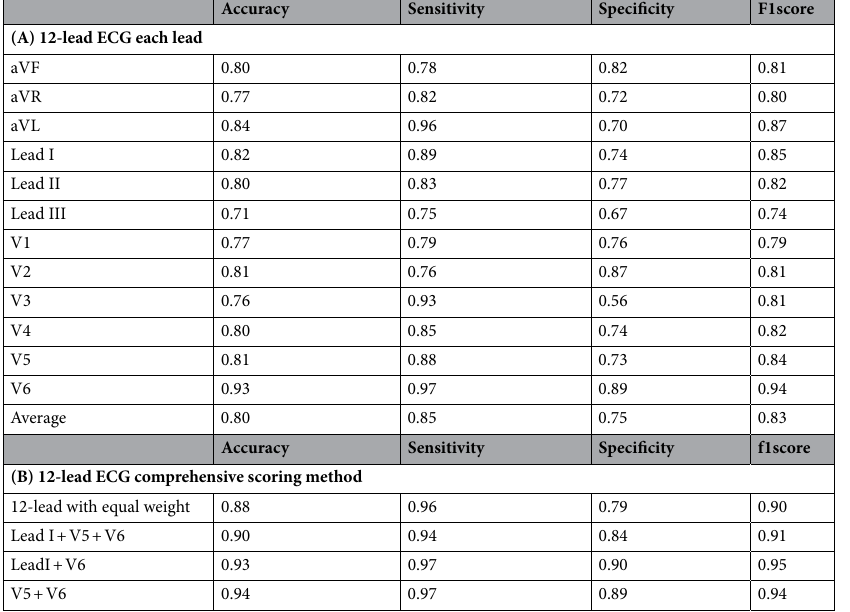
Table 3. 2D-CNN classification results. (A) reveals the results of the 12-lead ECG scoring methods. (B) presents the results of four comprehensive 12-lead ECG scoring